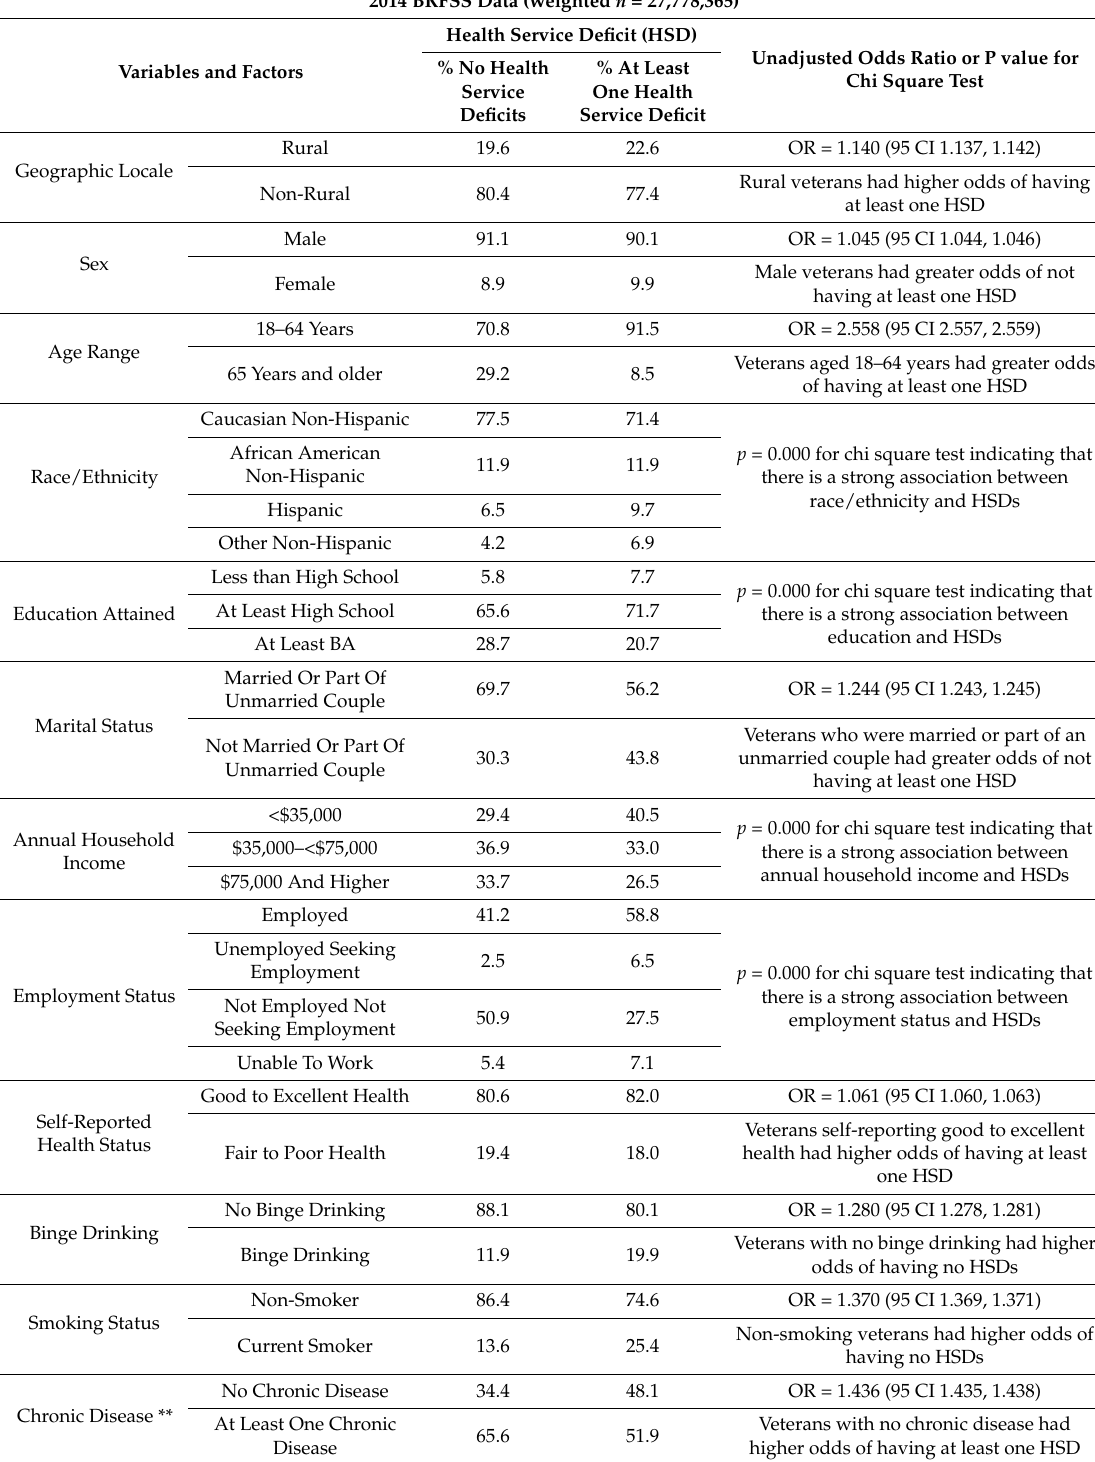
Table 2. Bivariate Analysis with Dependent Variable Health Service Deficit